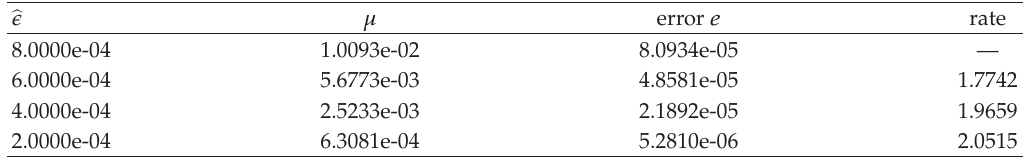
Table 2: Convergence. The error is e (cid:8) u ref is the numerical reference solution. The rate corresponds to the convergence with respect to (cid:28) (cid:3) . (cid:28)